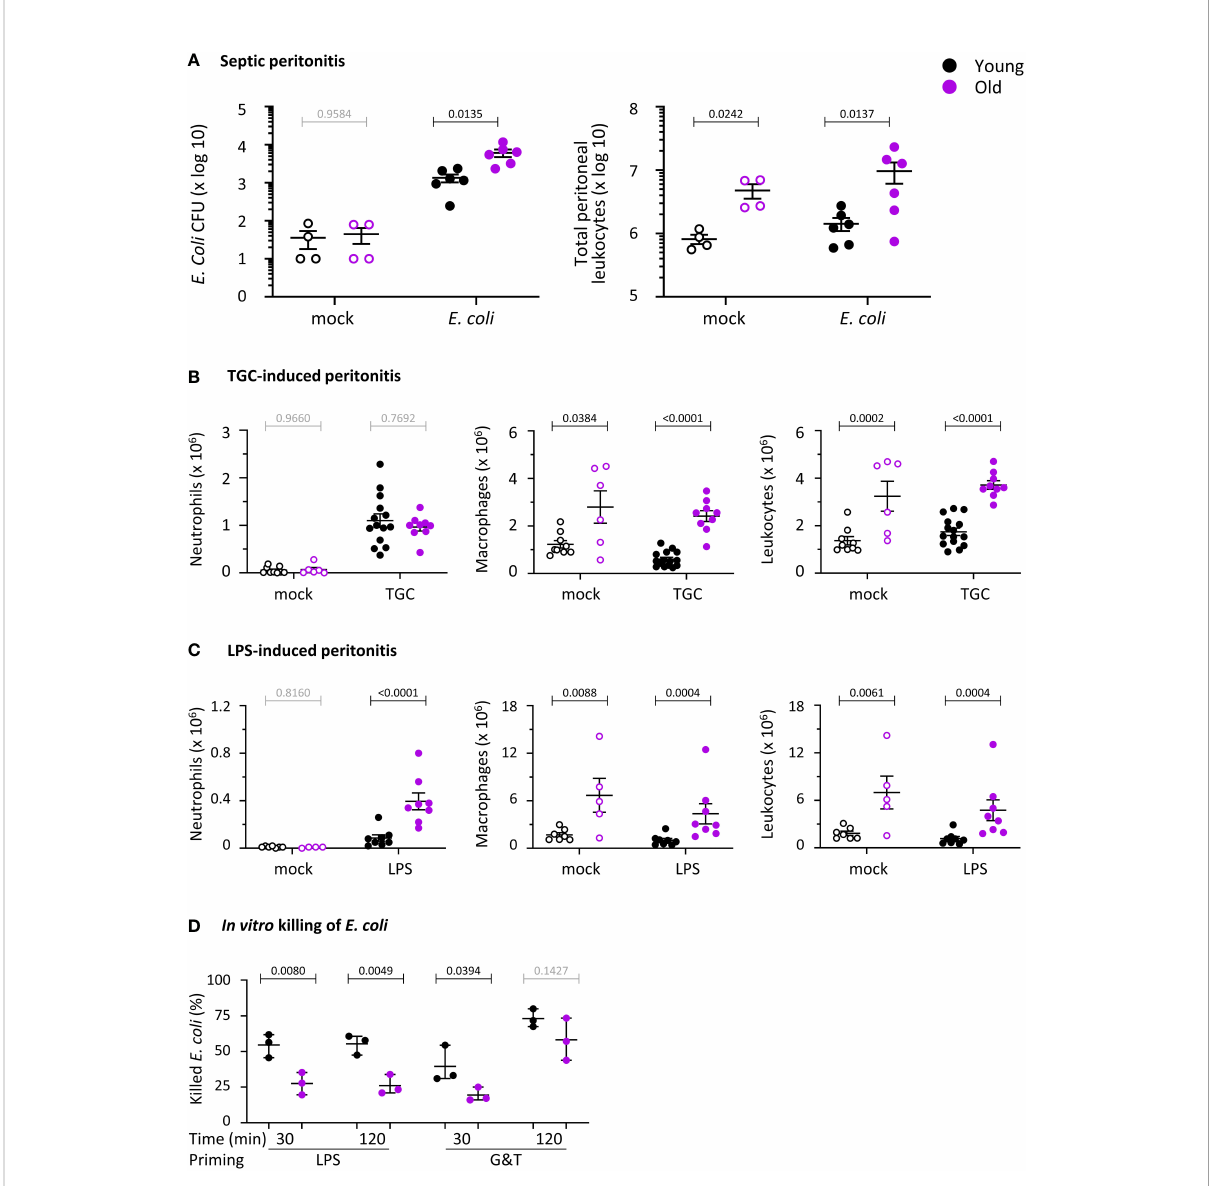
DC FIGURE 1 Hornigold K et al. Old mice have impaired immunity against E. coli infection and altered neutrophil recruitment, and the ability of their neutrophils to kill E. coli is reduced. (A) E. coli -induced septic peritonitis. Young (8-10 weeks, black symbols) and old (24 months, purple symbols) mice were infected i.p. with 1x10 4 pathogenic E. coli O18:K1 ( fi lled symbols), or were mock-infected (open symbols), and culled humanely 3 h later. Peritoneal lavages were performed and assessed for bacterial burden by bacterial culture and quanti fi cation of CFU. Lavage neutrophils and total leukocytes were quanti fi ed by microscopy. Data are mean ± SEM of mice pooled from 3 independent experiments, with 1- 2 mock-infected and 1-3 infected mice/age/experiment. (B) Aseptic peritonitis. Young and old mice were challenged i.p. with 0.25 ml sterile 3% thioglycollate (TGC, fi lled symbols), or were mock-treated (open symbols), and culled 3 h later. Peritoneal lavages were assessed for numbers of peritoneal neutrophils, macrophages and total leukocytes by hemocytometer and microscopy of cytospins. Data are mean ± SEM, pooled from 5 independent experiments, with 1-3 mock-treated and 1-4 TGC-treated mice/age/experiment. (C) LPS-induced septic peritonitis. Young and old mice were challenged i.p. with 250 ng LPS in 0.25 ml saline ( fi lled symbols), or were mock-treated with saline (open symbols), and culled 3 h later. Peritoneal lavages were assessed as in (B) . Data are mean ± SEM, pooled from 3 independent experiments, with 1-2 mock-treated and 2-3 LPS-treated mice/age/experiment; dots represent individual mice. Statistics in (A-C) are two-way ANOVA with Sidak ’ s multiple comparisons test on log-transformed raw data; black p-values are signi fi cant, grey p-values non-signi fi cant. (D) In vitro killing of E. coli . Neutrophils puri fi ed from young (8-10 weeks, black symbols) and old (24 months, purple symbols) mice were primed with 1 m g/ml LPS or with 20 ng/ml TNF a and 50 ng/ml GM-CSF, as indicated, or were heat-killed as a negative control, and were incubated with serum-opsonised E. coli DH5 a (ratio of 2.5 bacteria per neutrophil) at 37°C for 30 or 120 min. Bacterial killing by neutrophils was quanti fi ed by comparing CFU between samples containing live and heat-killed neutrophils. Data are mean ± SEM of 3 independent experiments; each dot represents the mean of one experiment. Statistics are three-way ANOVA with Sidak ’ s multiple comparisons test; black p-values are signi fi cant, grey p-values non-signi fi